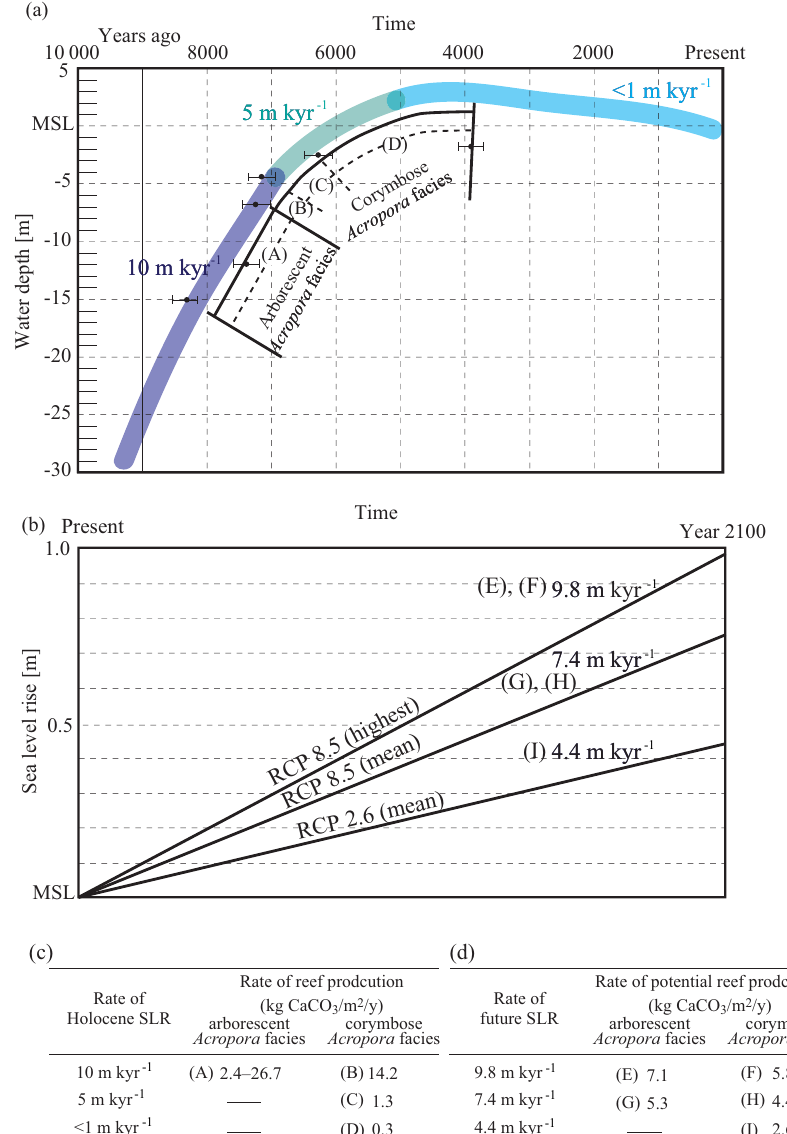
Figure 8. Past and future reef production rates at the study site. (a) Sedimentary facies and Holocene sea level curve relative to present m.s.l. at the study site. Solid circles represent 14 C ages obtained from the reef crest drill core (PL-I: Kayanne et al., 2002). Radiometric counter errors are given in terms of 2 standard deviations (2 σ) . The reef growth curve is from Kayanne et al. (2002). The thick line shows two facies (arborescent Acropora facies and corymbose Acropora facies), from Hongo and Kayanne (2011). The dashed lines (A–D) indicate the period for estimation of the reef production rate for each facies in response to Holocene sea level change. The sea level curve around the study site is from Chappell and Polach (1991), Yokoyama et al. (1996, 2016), and Hongo and Kayanne (2010). (b) Sea level curve projected for 2100. The SLR ranges from + 0.44 to + 0.98m until the end of the 21st century (RCP 2.6 and 8.5 scenarios; Church et al., 2013), equivalent to a SLR rate of 4.4–9.8mkyr − 1 . (E)–(I) Locations used for estimating reef production rates for each facies in response to future sea level change. (c) Holocene reef production rate based on drill core. (D) Future potential reef production rate for each facies if the reef remains